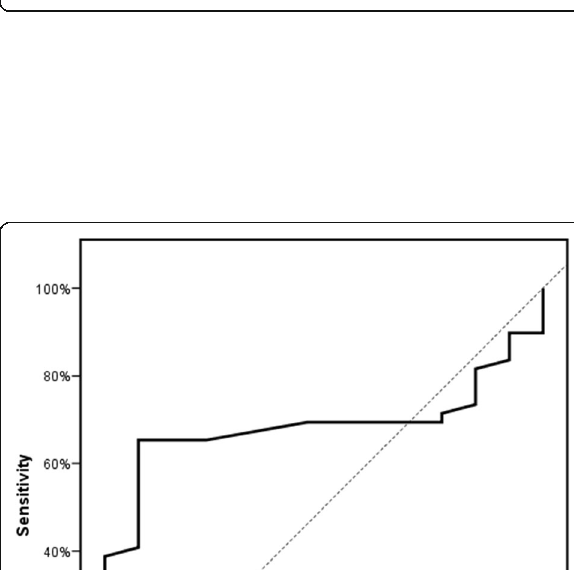
Fig. 4 ROC curve to assess agreement (sensitivity, specificity) of the ADC value to diagnose cases with clear cell RCC from other tumors. Cutoff ADC value of > 1.1 × 10 − 3 mm 2 /s can be used to distinguish cases of clear cell RCC from other tumors with a sensitivity of 72.41% and a specificity of 95.74%